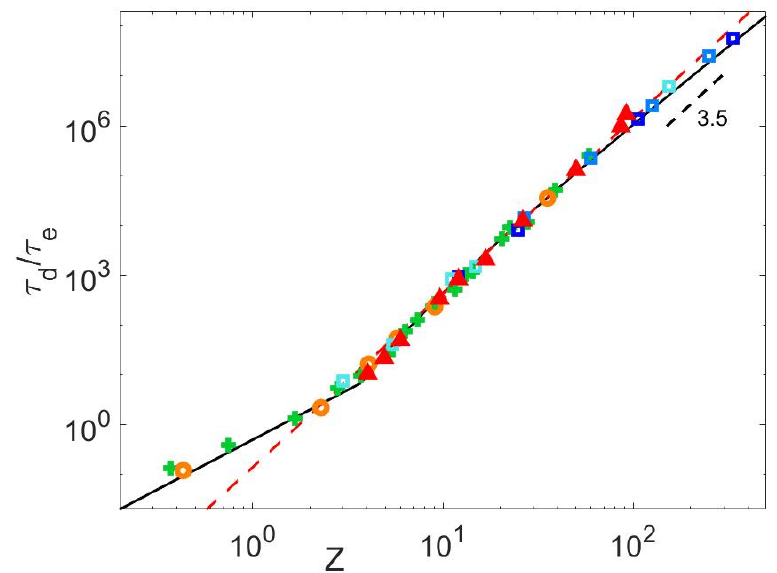
Figure 9. Normalized final relaxation times of monodisperse PS (green +), PI (red ∆ ) PMMA (orange ) and PBD (blue ) samples from Refs. [14,24–28,30,40,41] and measured in this article, obtained from < τ d > = lim [3], as a function of their number of entanglements, compared to the predictions of Equation (21) (black curve) and to the approximation τ d / τ e ∼ 0.14 Z 3.5 (dashed red curve).